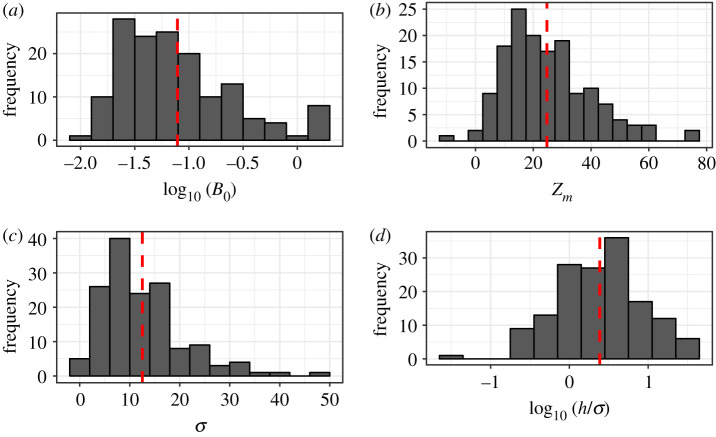
Histograms of chlorophyll profile parameters for the combined profile dataset. (a) B0 represents the background chlorophyll concentration, (b) zm is the depth of the peak chlorophyll concentration, (c) σ is the width of the Gaussian and (d) h/σ indicates the steepness of the slope of the peak. Vertical dashed lines indicate mean parameter values (B0 = 0.19, zm = 24.7, σ = 12.42, h/σ = 4.91). (Online version in colour.)